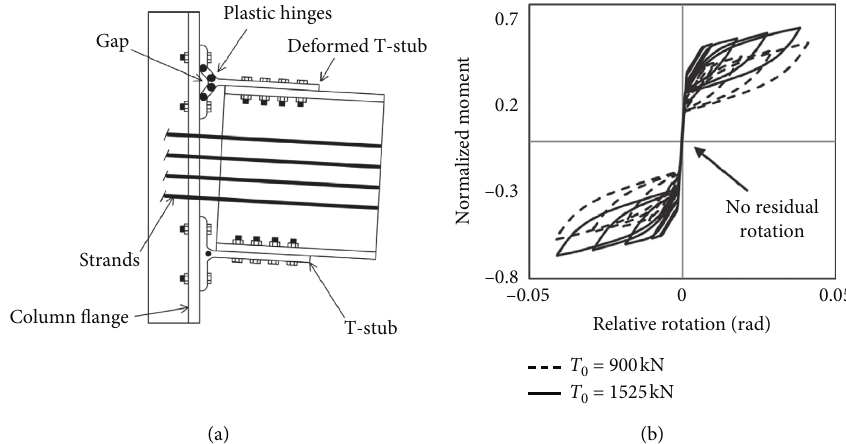
Figure 4: Deformation and behavior of PTTC. (a) Deformation of PTTC (adapted from [15]). (b) Normalized moment-relative rotation relationships (adapted from